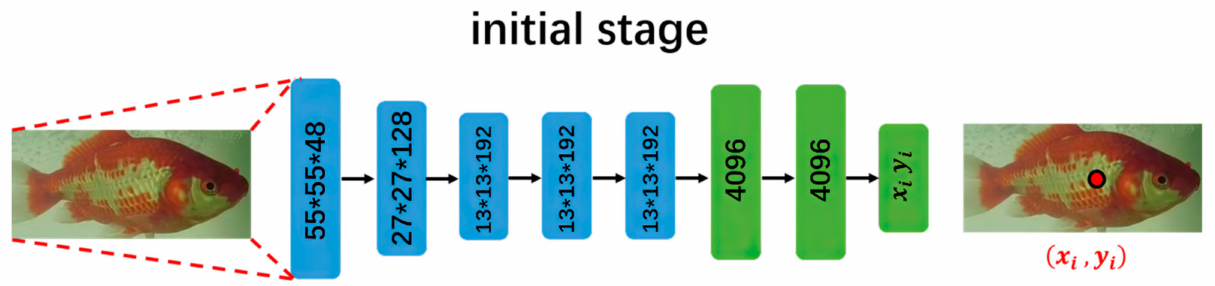
Figure 10. A schematic diagram of crucian carp’s DNN-based posture regression in the DeepPose network. We use the corresponding dimensions to visualize the network layer, where the convolutional layer is blue and the fully connected layer is